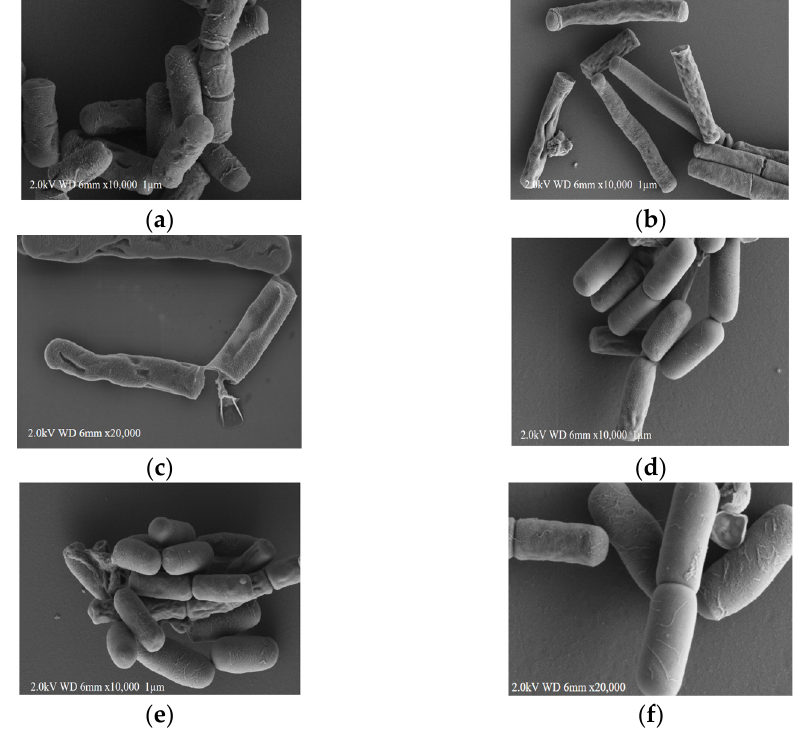
Figure 2. FE-SEM studies of mesophilic B. cereus group strain (BCG T ) and psychrotolerant B. cereus group strain (BCG 34 ) grown at 30 °C ( a , d ) and 10 °C ( b , c , e , f ). BCG T at 30 °C ( a ), BCG T at 10 °C ( b , c ), BCG 34 at 30 °C ( d ), and BCG 34 at 10 °C ( e , f ). Cell division occurs in different stages: DNA duplication, lengthening of cells, sep-